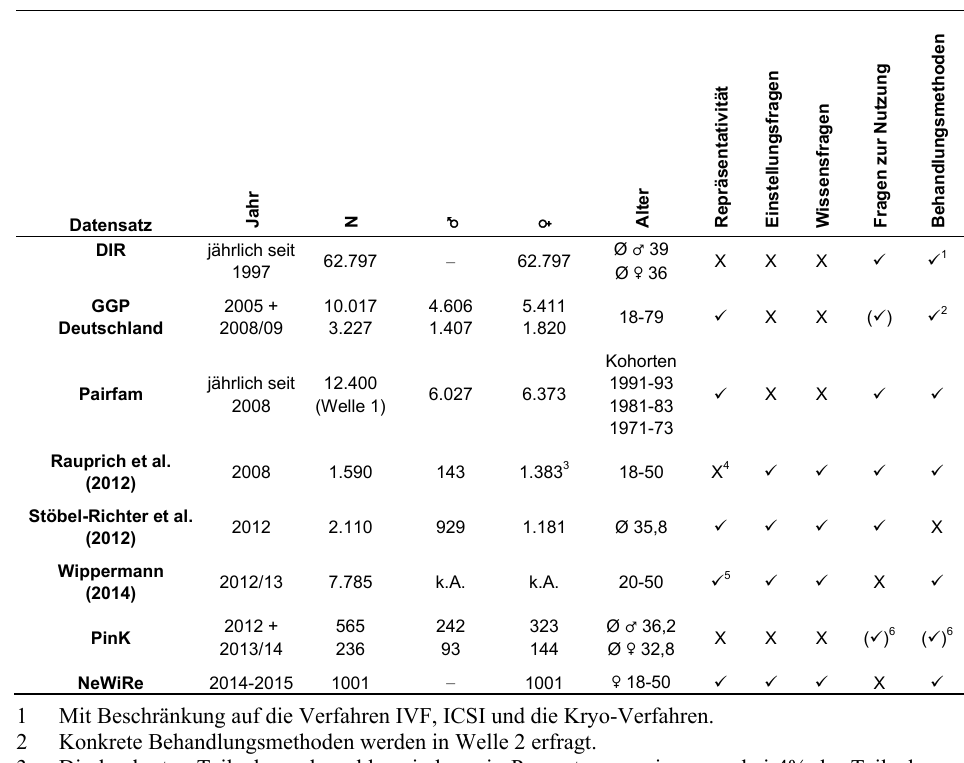
Tabelle 2 : Reproduktionsmedizinische Analysepotentiale